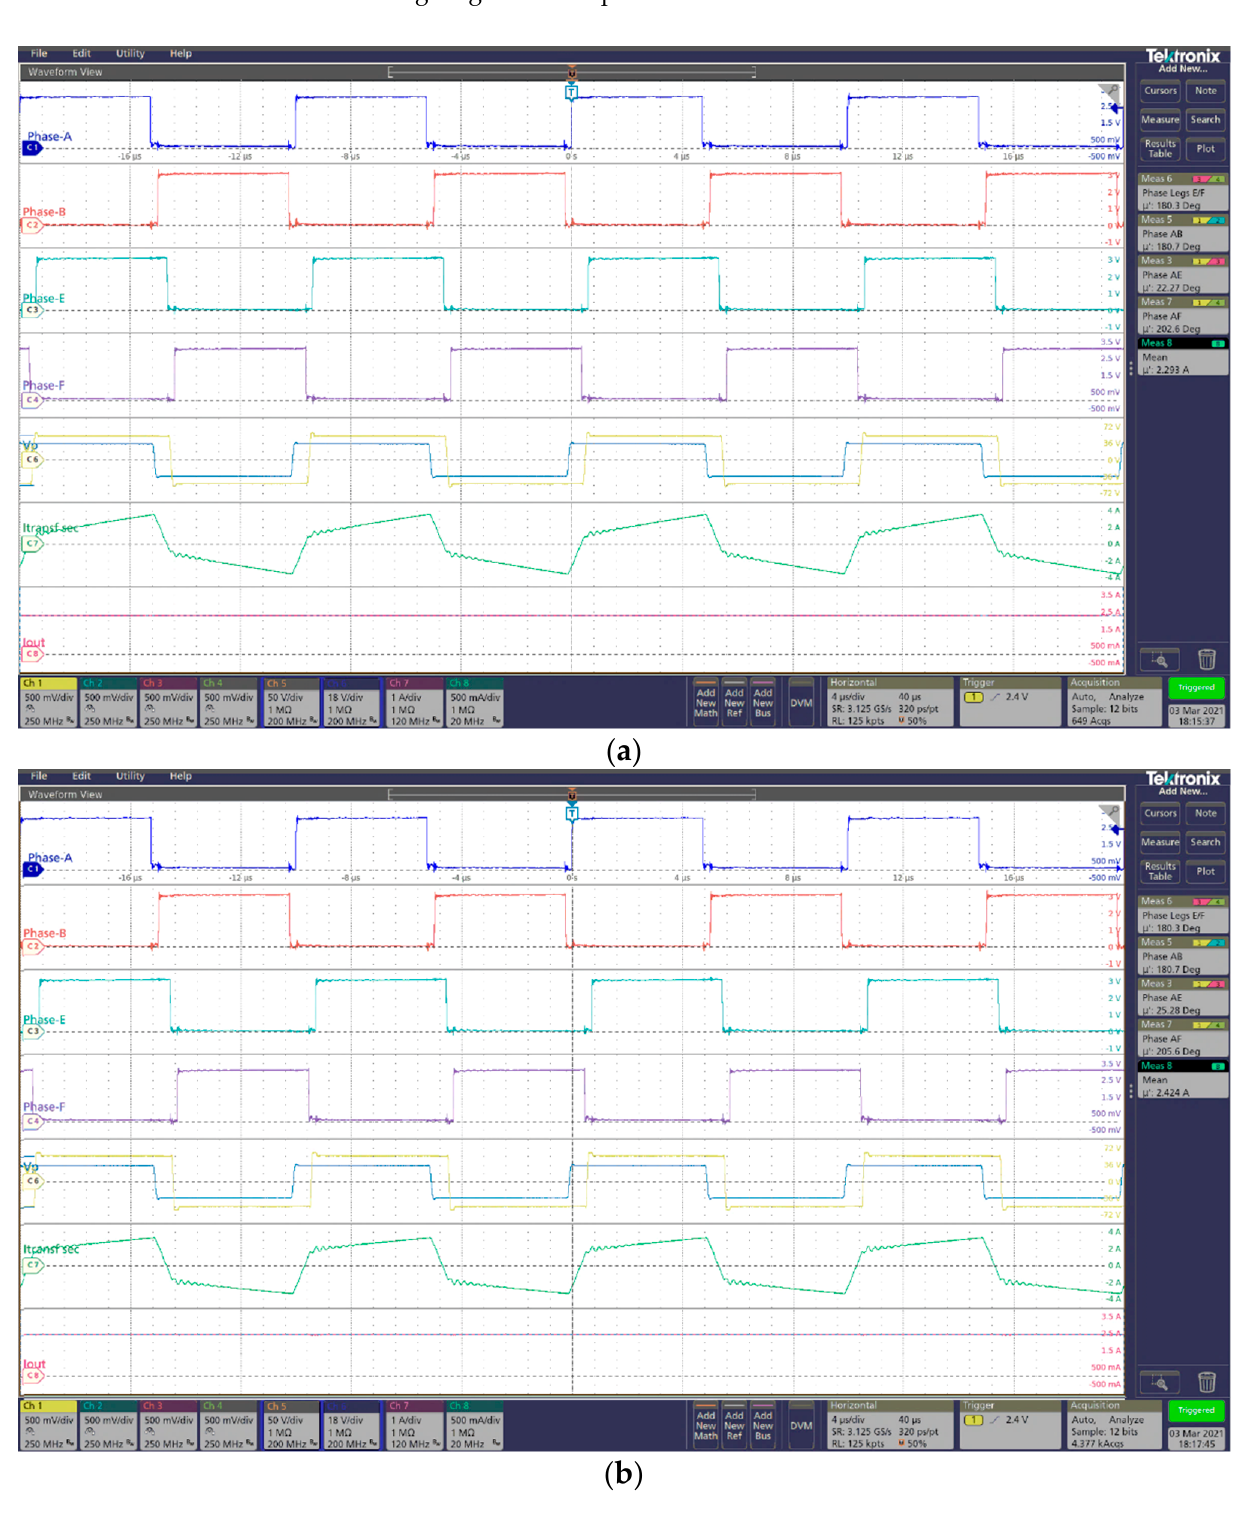
Figure 16. Gate control signals, transformer’s primary and secondary voltage, inductor current and output current average of the experimental model at 100 kHz: ( a ) Case 2; ( b ) Case 3.